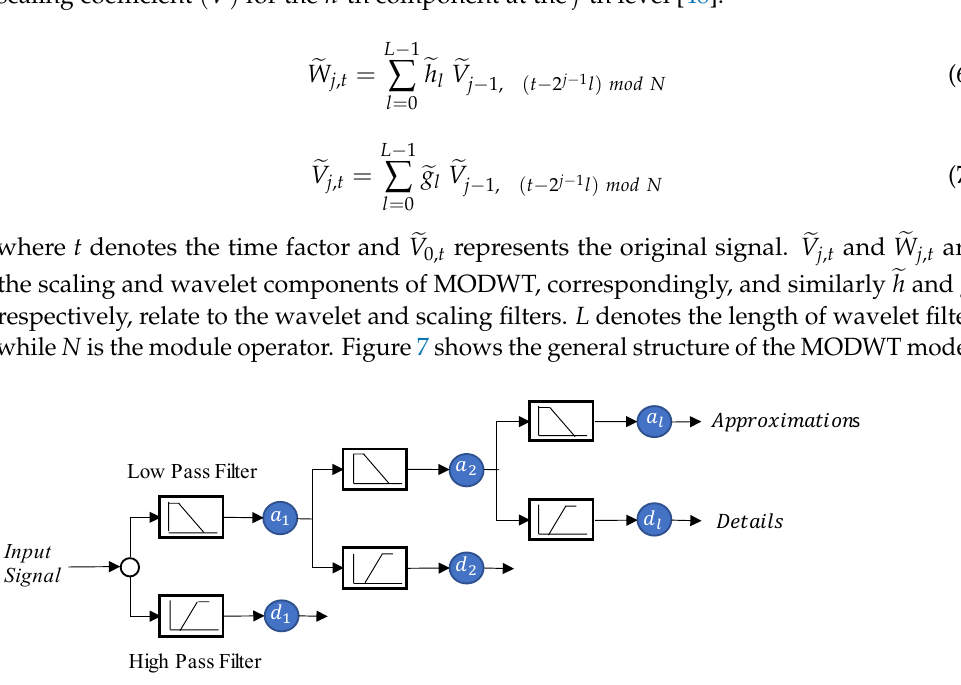
Figure 7. MODWT structure with low-pass and high-pass filters (reproduced from Hammad et al. [25]).